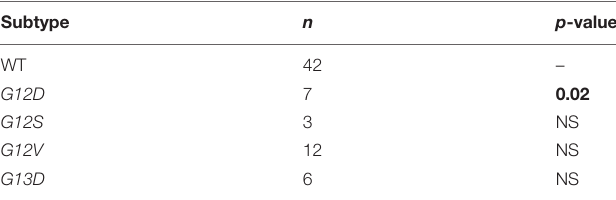
TABLE 5 | Kaplan–Meier analysis of progression-free survival.